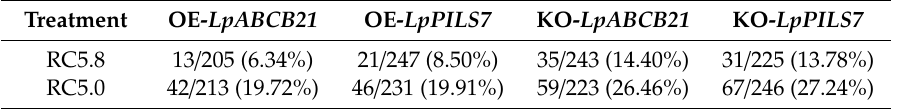
Table 1. The number of resistant calli under various transformation conditions.